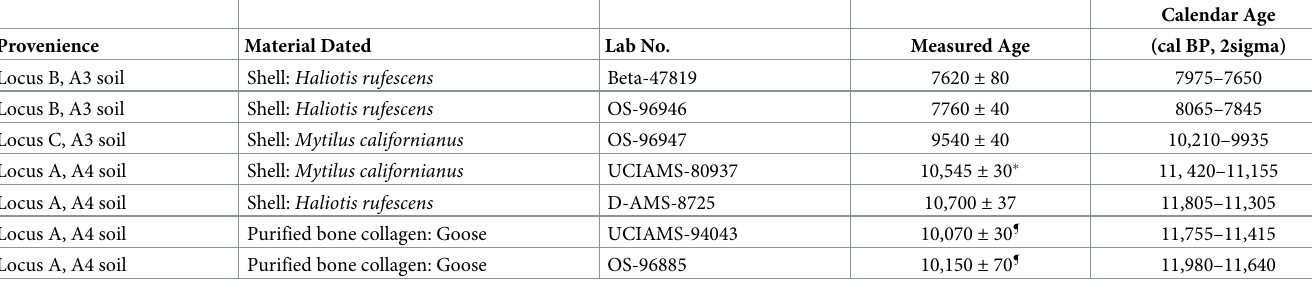
Table 1. 14 C dates from terminal Pleistocene and Early Holocene components at